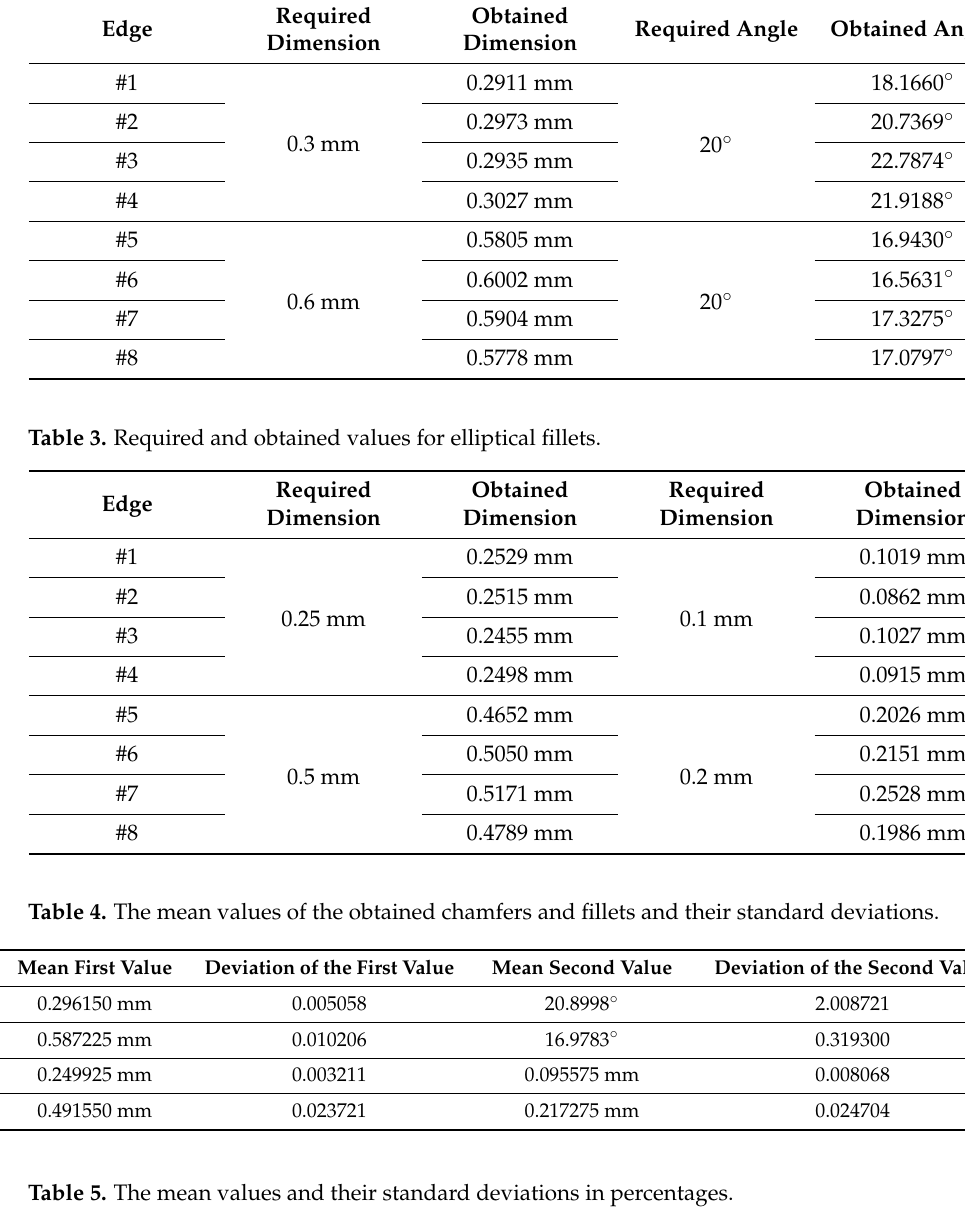
Table 5. The mean values and their standard deviations in percentages.